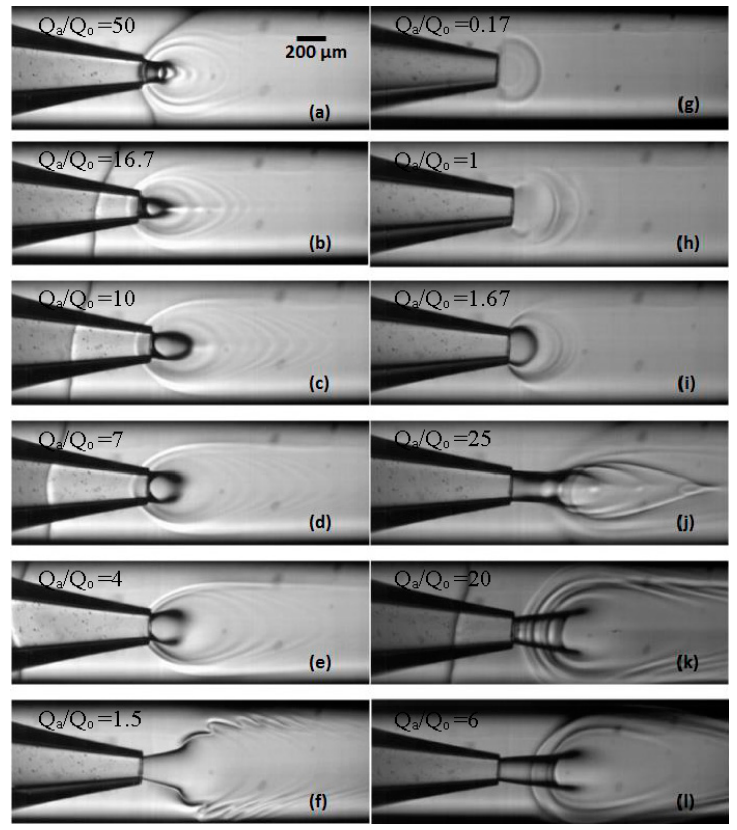
Figure 5. Experimental images using a co-flow device (tip size = 160 μ m) from a high speed camera with varying aqueous phase flow rates (Q a ) and organic phase flow rates (Q o ): ( a ) Q a = 5 mL h − 1 , Q o =